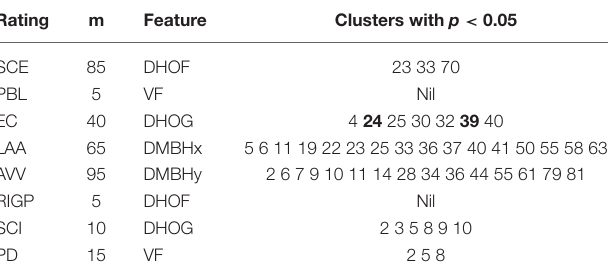
TABLE 9 | Statistically significant clusters of video segments for each rating/skill, where the bold cluster number has the higher value for good presenters, and the remaining cluster numbers have higher value for bad